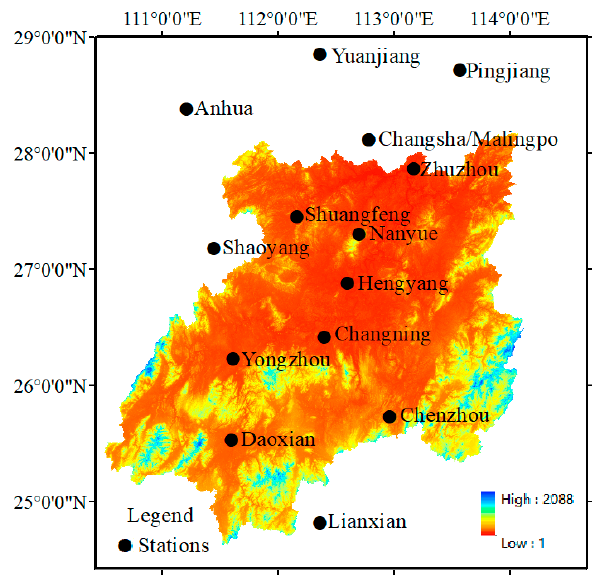
Figure 1. Xiang River Basin and distribution of the meteorological stations.